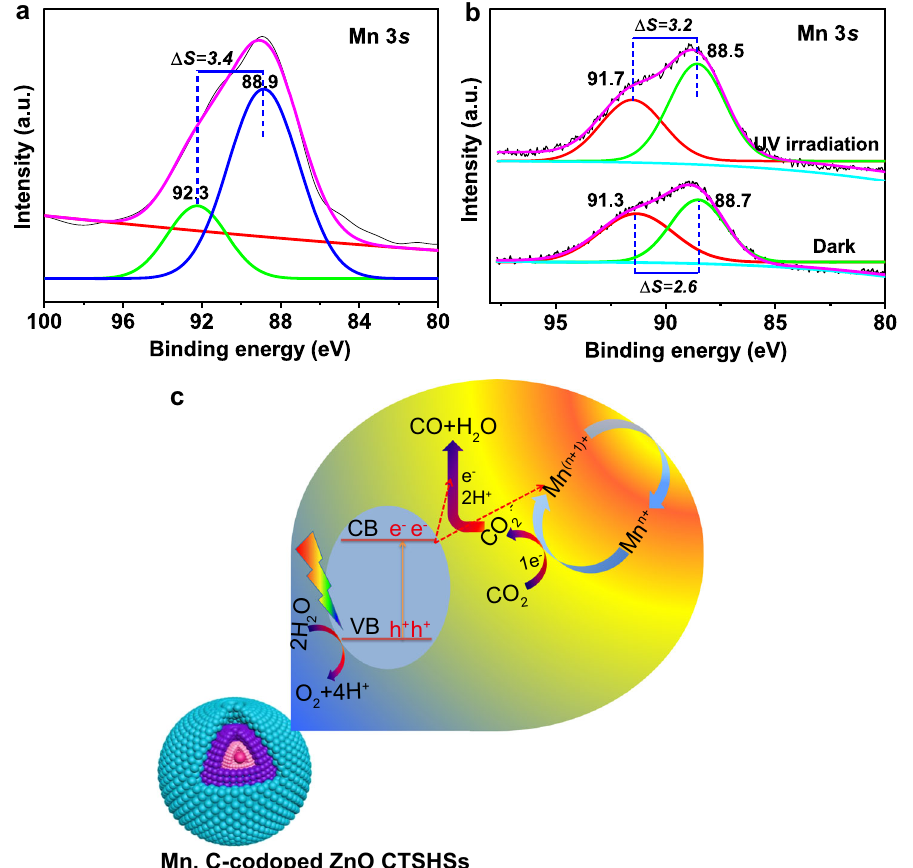
Fig. 6 Interpretation of the CO 2 reduction mechanism over Mn, C-ZnO photocatalyst. In situ XPS analysis showed Mn 3 s pro fi les for a untreated and b CO 2 -adsorbed Mn, C-ZnO CTSHS samples. The multiple splitting of Mn 3 s ( Δ S ) is used to calculate average oxidation state of Mn ions within the structure (Eq. (1)). c Schematic illustration of CO 2 activation and reduction over Mn, C-codoped ZnO sample. The CO 2 molecules are fi rstly activated at the con fi ned Mn active centers to the highly active radical anion. Such intermediate anion is then subjected to successive electron-coupled proton transfer process (electrons from ZnO CB and protons from water) and fi nally produces CO. The photogenerated holes are consumed for water oxidation (oxygen evolution